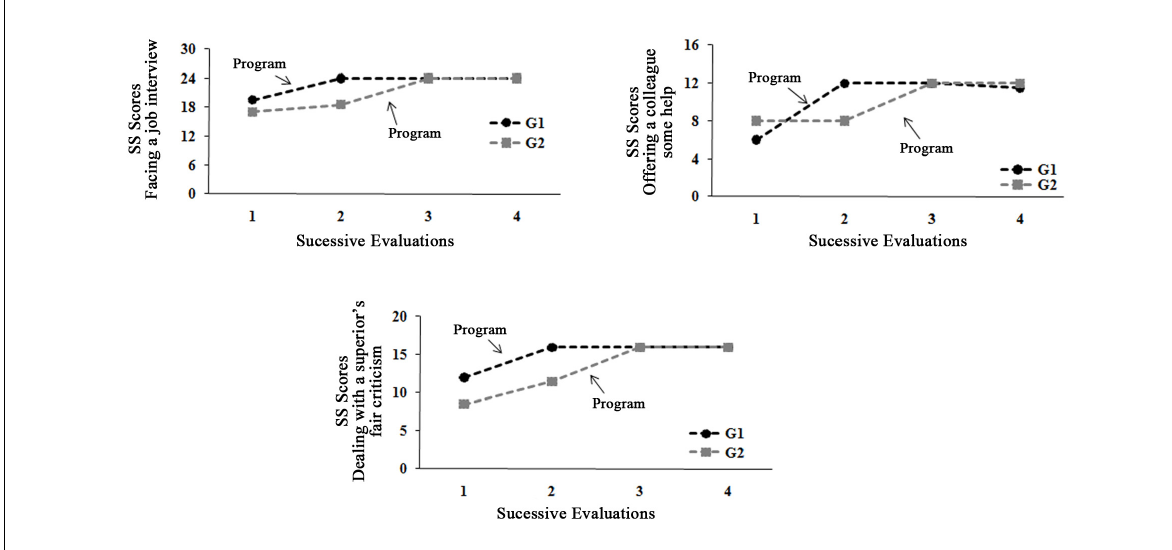
Figure 2. Median of the scores that were achieved by the participants of G1 and G2 in the Structured Situations (SS) of: Facing a job interview , Offering a colleague some help and Dealing with a superior’s fair criticism